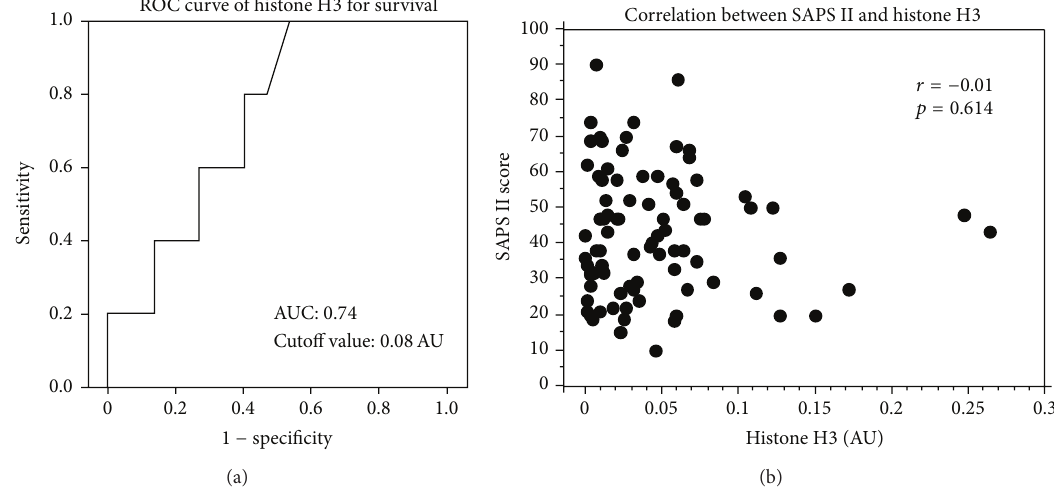
Figure 4: ROC curve for histone H3 for death and correlation between SAPS II and histone H3. ROC curve analysis calculated AUC for histone H3 on Day 7 for death. AUC was 0.740 (95% CI: 0.513–0.967). The cutoff value of the histone H3 was 0.08 AU (a). No significant correlation between SAPS II score and histone H3 level on Day 7 was recognized ( 𝑟 = −0.01 , 𝑝 = 0.614 (b)). SAPS II: Simplified